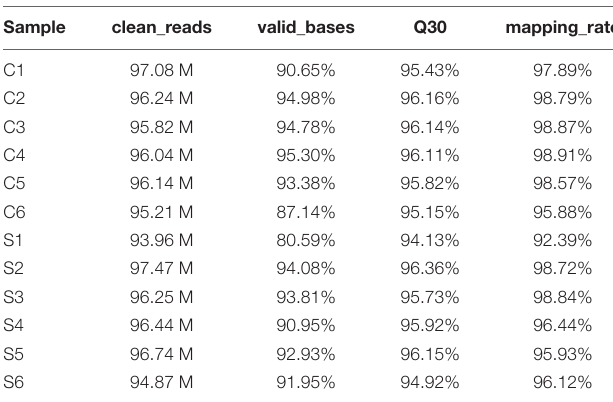
TABLE 3 | Statistics of the sequencing data.